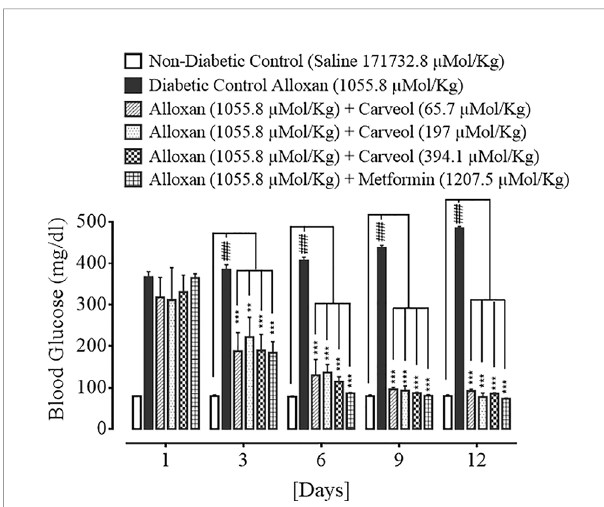
FIGURE 3 | Bar graph representing blood glucose level on different treatment days of the saline-treated group (non-diabetic control), alloxan-treated group (diabetic control), carveol-treated groups at different doses (65.7, 197, 394.1 µMol/Kg), and metformin-treated group against alloxan-induced hyperglycemia in rats. Data presented as mean ± SEM. Statistical analysis used one-way ANOVA, followed by post-hoc Tukey ’ s test. ### p < 0.001 vs. saline group, ** p < 0.01 and *** p < 0.001 comparison of the blood glucose levels of carveol- and metformin-treated groups vs. diabetic control group.